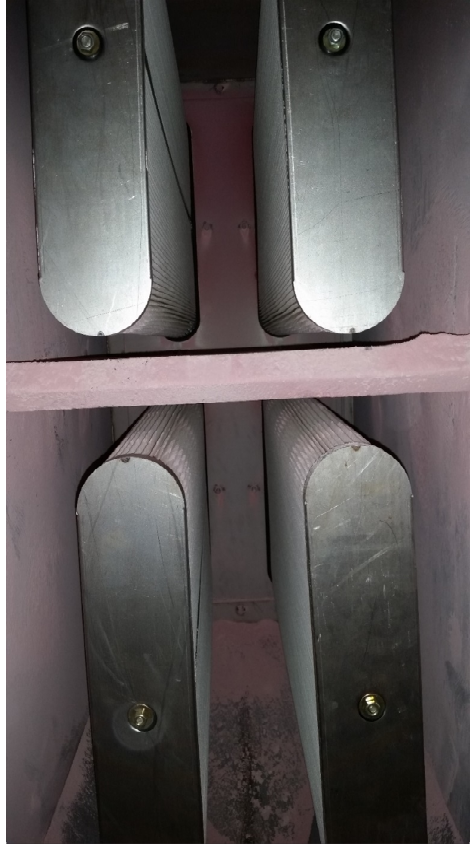
Table 2. The specifications of the filter for the experiment.